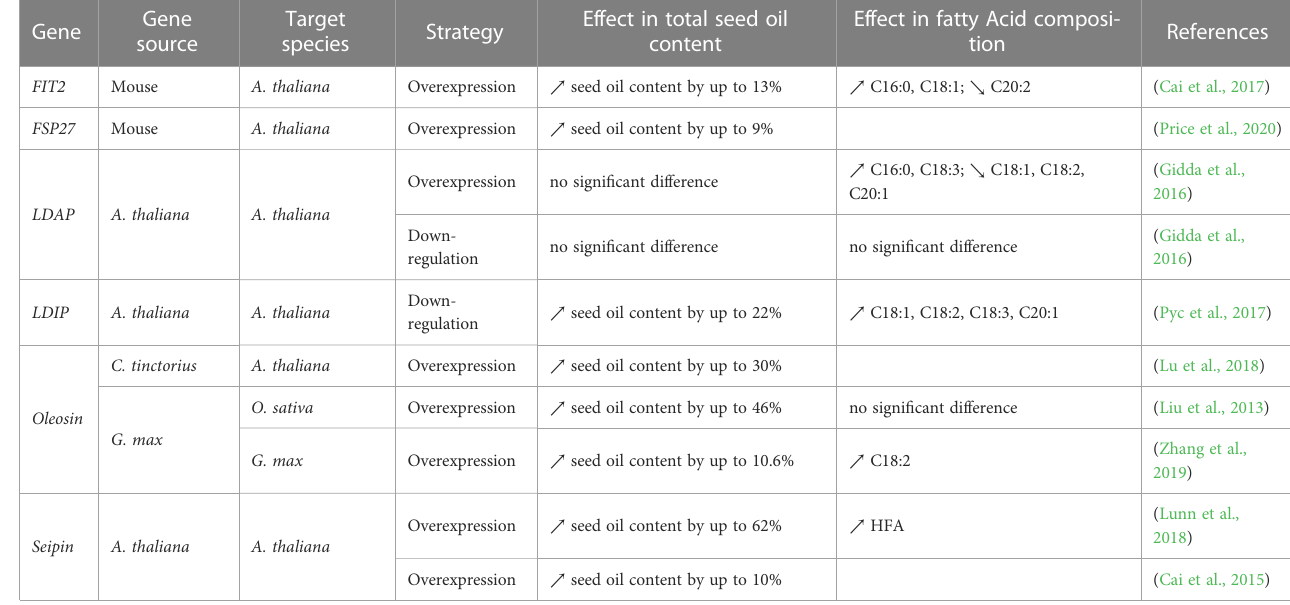
TABLE 6 List of “ package ” genes manipulated to enhance oil yield and/or change the FA composition in seeds. Gene Gene